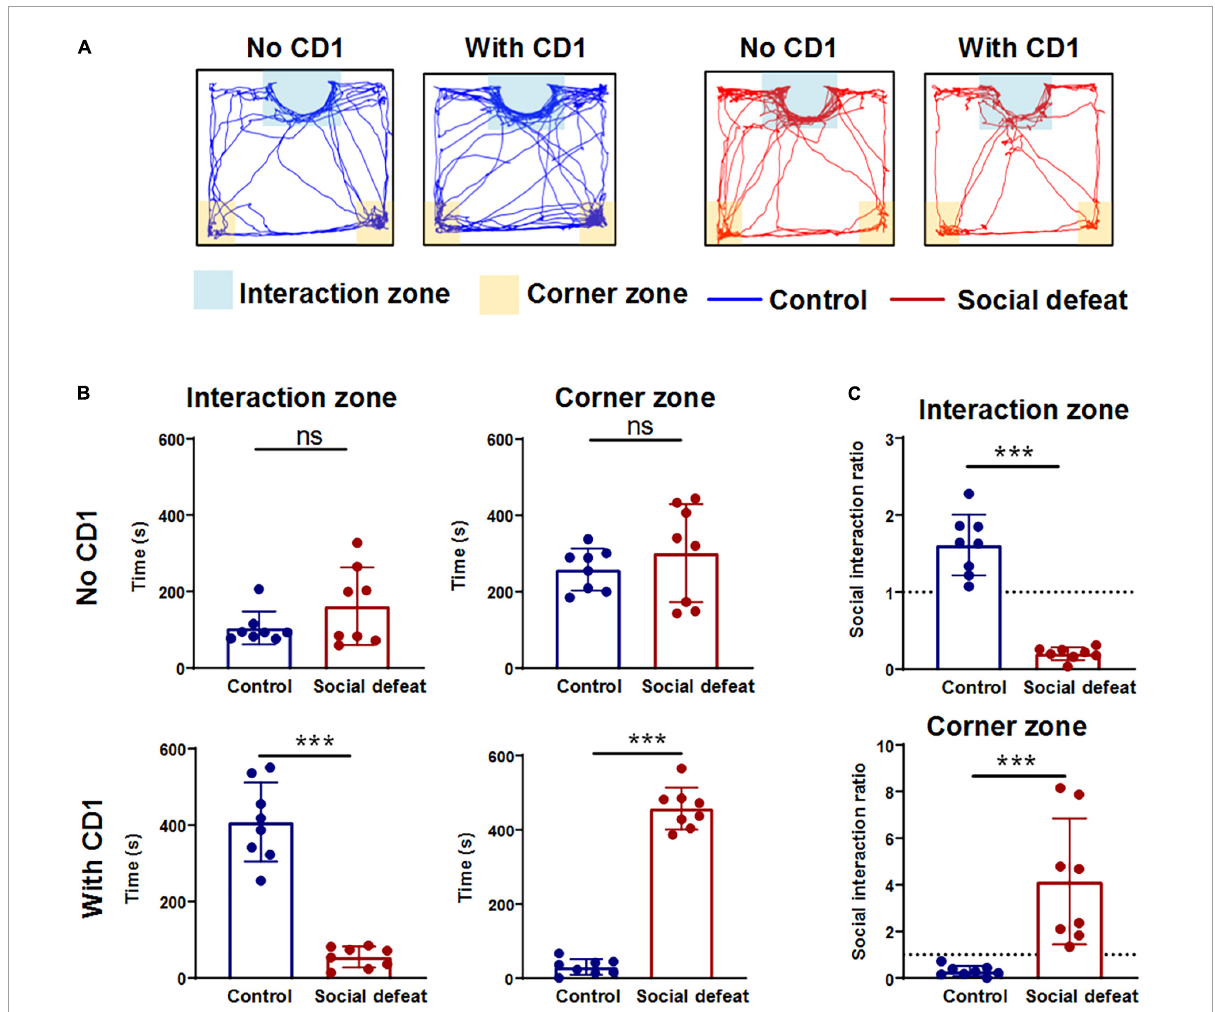
FIGURE2 Effects of chronic social defeat stress on mice social behaviors. (A) Representative activity tracking during the social interaction test for control and socially defeated mice in the absence or presence of a CD1 target. (B) Summary plots of time in interaction zone and time in corner zone of the two groups in the absence or presence of a CD1 target (control, n = 8 mice; social defeat, n = 8 mice). (C) Plots of the social interaction ratio in interaction zone and corner zone for control and socially defeated mice. All data are presented as the mean ± SEM. *** p < 0.001. Time in interaction zone, No CD1: (control: 258.2414 ± 18.2320; social defeat: 301.3191 ± 42.5101; unpaired t -test, t = 0.8712, p = 0.3984). Time in corner zone, No CD1: (control: 104.6443 ± 14.1879; social defeat: 161.5693 ± 33.5602; unpaired t -test, t = 1.4610, p = 0.1660). Time in interaction zone, With CD1: (control: 408.3468 ± 34.1674; social defeat: 55.2361 ± 9.0972; unpaired t -test, t = 9.3420, *** p < 0.001). Time in corner zone, With CD1: (control: 30.4027 ± 6.9439; social defeat: 457.2912 ± 18.7106; unpaired t -test, t = 20.010, *** p < 0.001). Social interaction ratio in interaction zone: (control: 1.6102 ± 0.1300; social defeat: 0.2004 ± 0.0276; unpaired t -test, t = 9.919, *** p < 0.001). Social interaction ratio in corner zone: (control: 0.2966 ± 0.0722; social defeat: 4.1410 ± 0.8949; unpaired t -test, t = 4.0060, *** p <